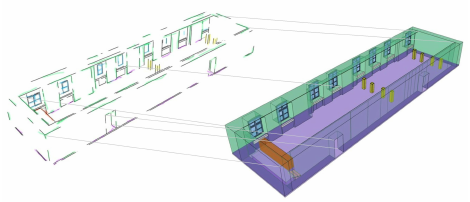
Figure 4. Assignment of semantic 3D line segments to corresponding model